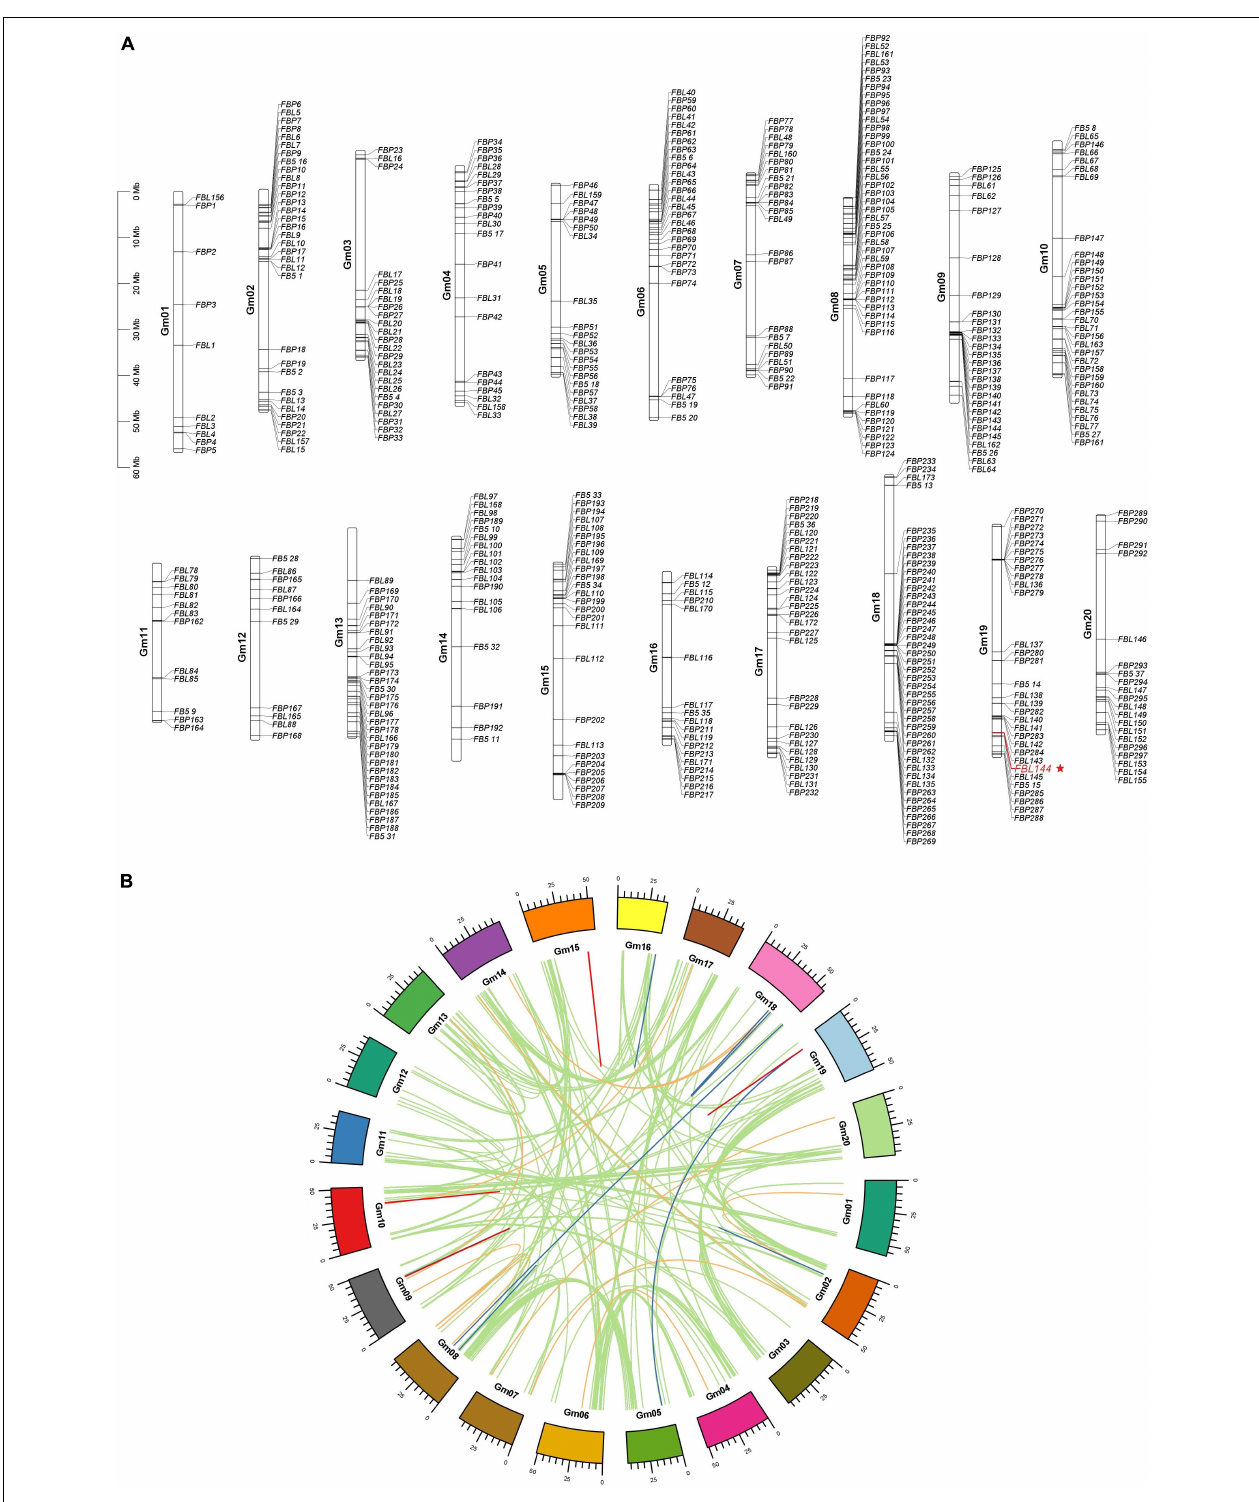
FIGURE 1 | Chromosome distribution and gene duplication analysis of GmF-box genes. (A) Chromosome distribution of GmF-box genes. (B) Gene duplication analysis of GmF-box genes. The GmF-box gene family expansion was primarily caused by WGD/segmental duplication. WGD/segmental duplications gene pairs are shown in green lines; tandem duplication gene pairs are shown in red lines; dispersed duplication gene pairs are shown in orange lines; proximal duplication gene pairs are shown in blue lines.